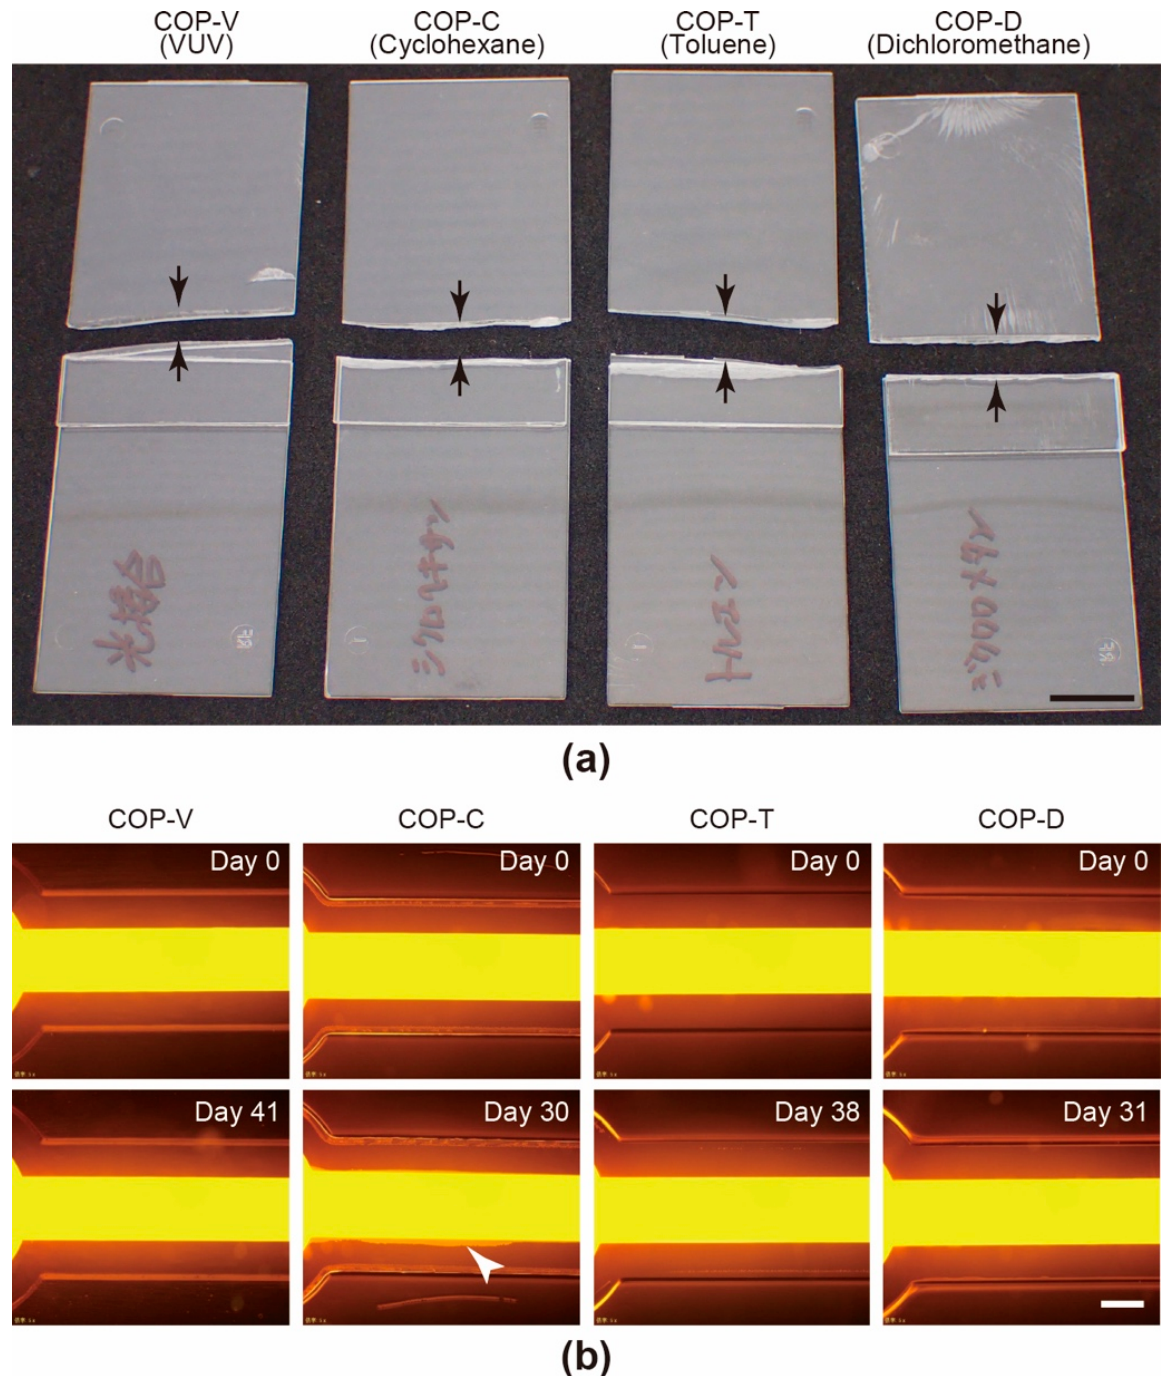
Figure 4. ( a ) Photographs captured after the peeling tests conducted to evaluate the bonding strengths of cyclo-olefin polymer (COP) microfluidic devices fabricated by vacuum ultraviolet (VUV) photobonding (COP-V) or solvent bonding using cyclohexane (COP-C), toluene (COP-T), or dichloromethane (COP-D). Scale bars: 10 mm. ( b ) Fluorescent micrographs captured after leakage tests of COP microfluidic channels fabricated by solvent- and VUV-bonding processes. To visualize the leakage, a 0.05% solution of Acid Red 52 was introduced into the MPS microfluidic channels and incubated. The white arrowhead indicates the leakage area for the COP-C device. Scale bars: 500 µm.